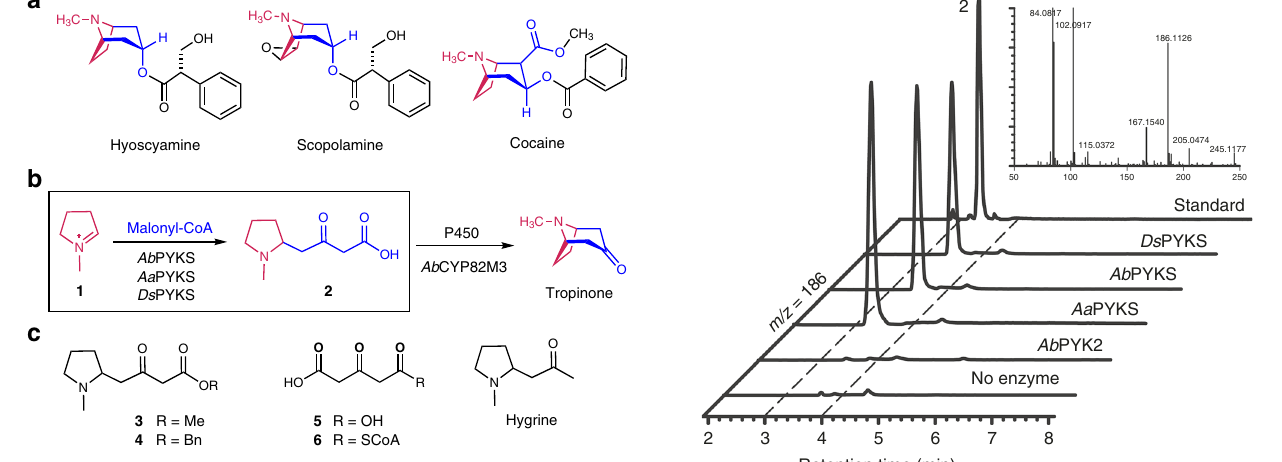
Fig. 1 The chemical structures mentioned in this study and the biosynthetic pathway of tropinone. a The tropane alkaloids. b The tropinone biosynthesis pathway with the current study highlighted in the box. c The chemical structures of other compounds